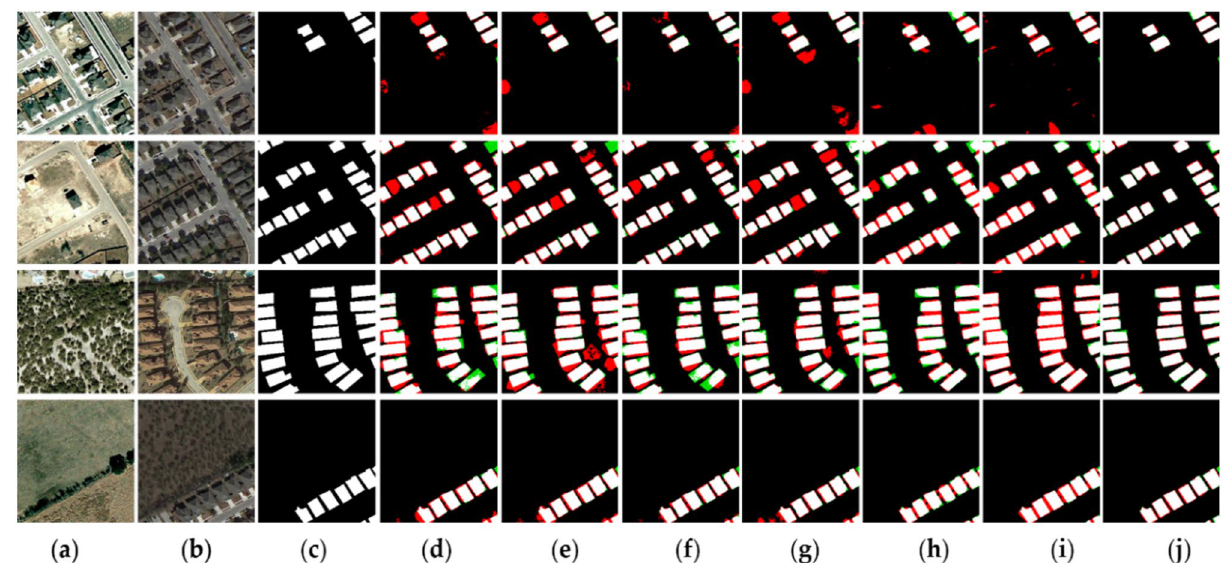
Figure 6. Bitemporal remote sensing images from LEIVR-CD dataset. The ( a ) are change before images; the ( b ) are change after images; the ( c ) represents the changed areas and the unchanged areas; ( d ) are results obtained by CDNet; ( e ) are results obtained by FC-EF; ( f ) are results obtained by FC-Siam-Diff; ( g ) are results obtained by FC-Siam-Conc; ( h ) are results obtained by DASNet; ( i ) are results obtained by STANet; ( j ) are results obtained by MFPF-Net (created by ‘Microsoft Office Visio 2013’ url: https:// www. micro soft. com/ zh- cn/ micro soft- 365/ previ ous- versi ons/ micro soft- visio- 2013).